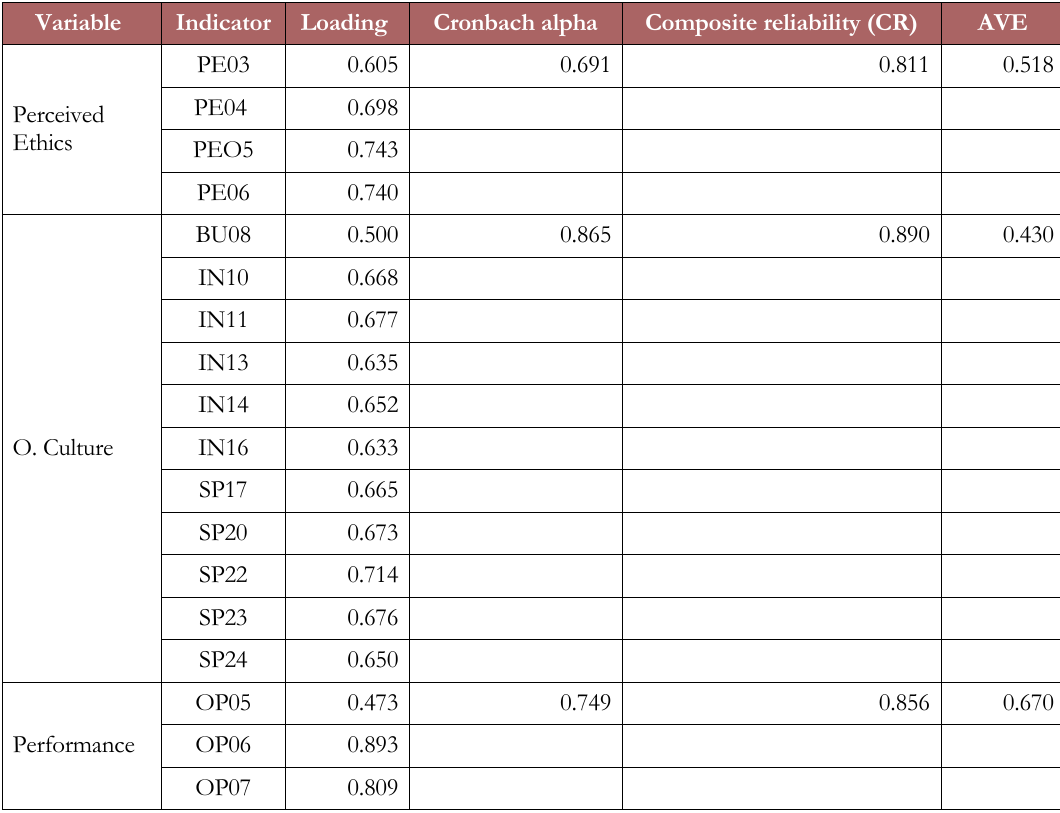
Table 4. Reliability and Validity of Constructs